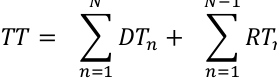
Table 1. Structure of travel time ( TT )